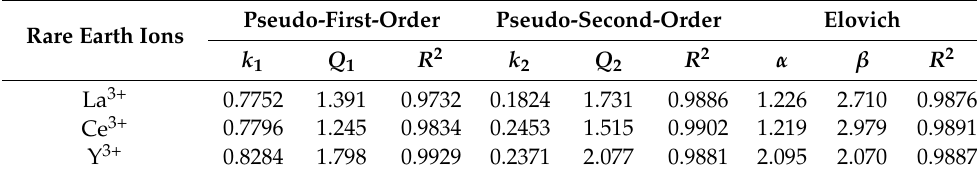
Figure 7. Linear plots of different kinetic models: ( a ) Pseudo-first-order model; ( b ) pseudo-second- order model; ( c ) Elovich equation. Table 6. Kinetic parameters of different models.